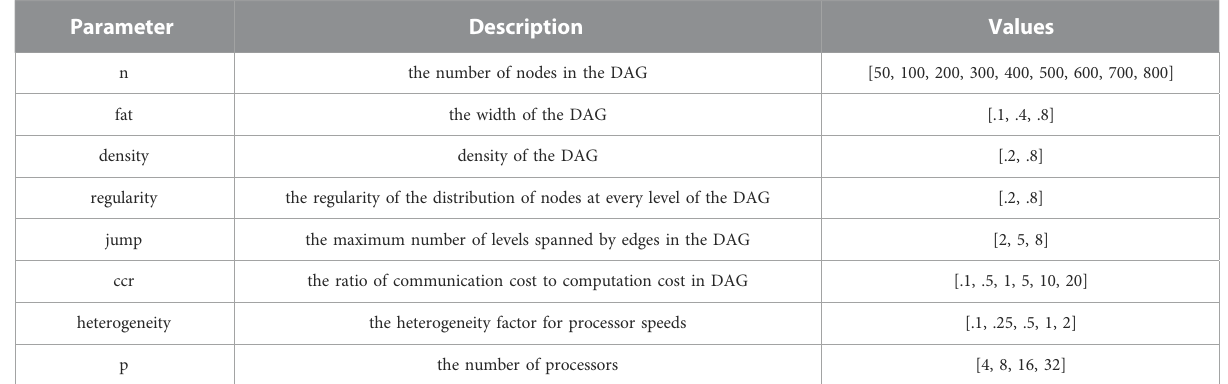
TABLE 5 Parameters used in simulation studies.